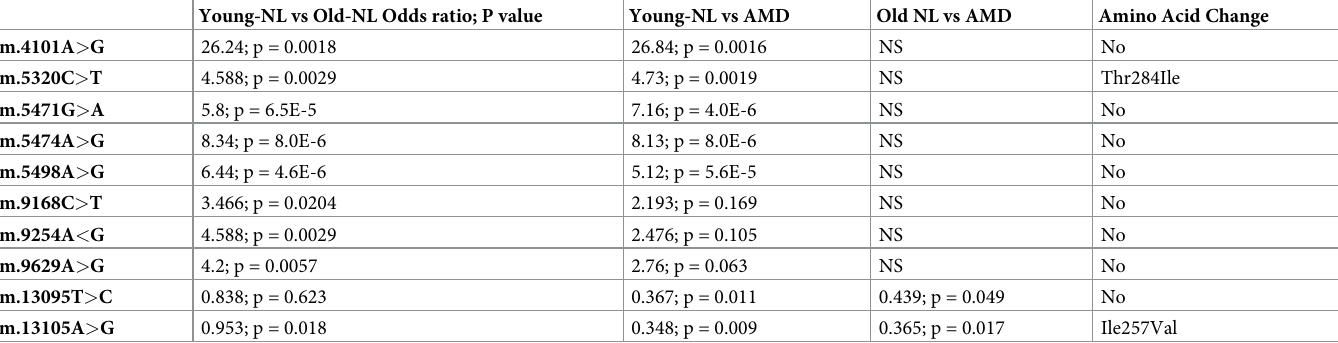
instrument using v2 chemistry (Illumina) that identified single nucleotide variant hetero- plasmy greater than 3% and large indels (greater than1 kb) with heteroplasmy > 30%. It has been generally felt that the exome sequencing does not deliver adequate coverage of the mtDNA and a new diagnostic approach is desirable. More recently, Trounce et al., used next- generation sequencing (NGS) to identify the mtDNA haplogroups and genetic burden of rare variants from blood of patients with open angle glaucoma [42]. However, they did not analyze for low frequency heteroplasmy SNPs. A different approach used for forensic identification of fragmented mtDNA is a whole genome panel that is a 2 pool multiplex assay of 81 primer pairs with minimal overlap in each pool (Precision ID mtDNA Whole Genome Panel, Thermo Fisher Scientific). This system has been designed for analyses of degraded DNA and is not typ- ically used for research or disease association. Table 9. List of heteroplasmy SNPs comparing young-NL, older-NL and AMD groups. Young-NL vs Old-NL Odds ratio; P